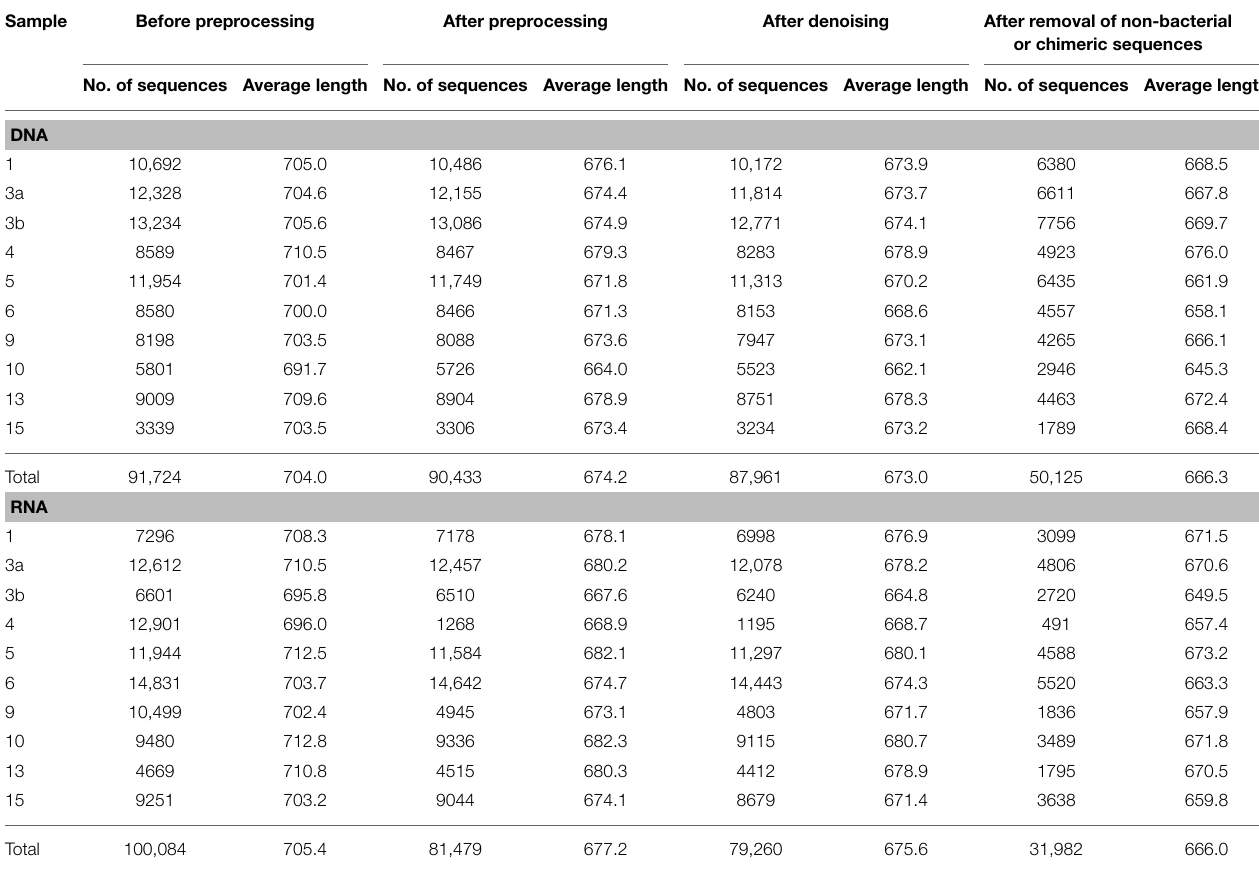
TABLE 6 | Statistics of the 16S rRNA analysis.